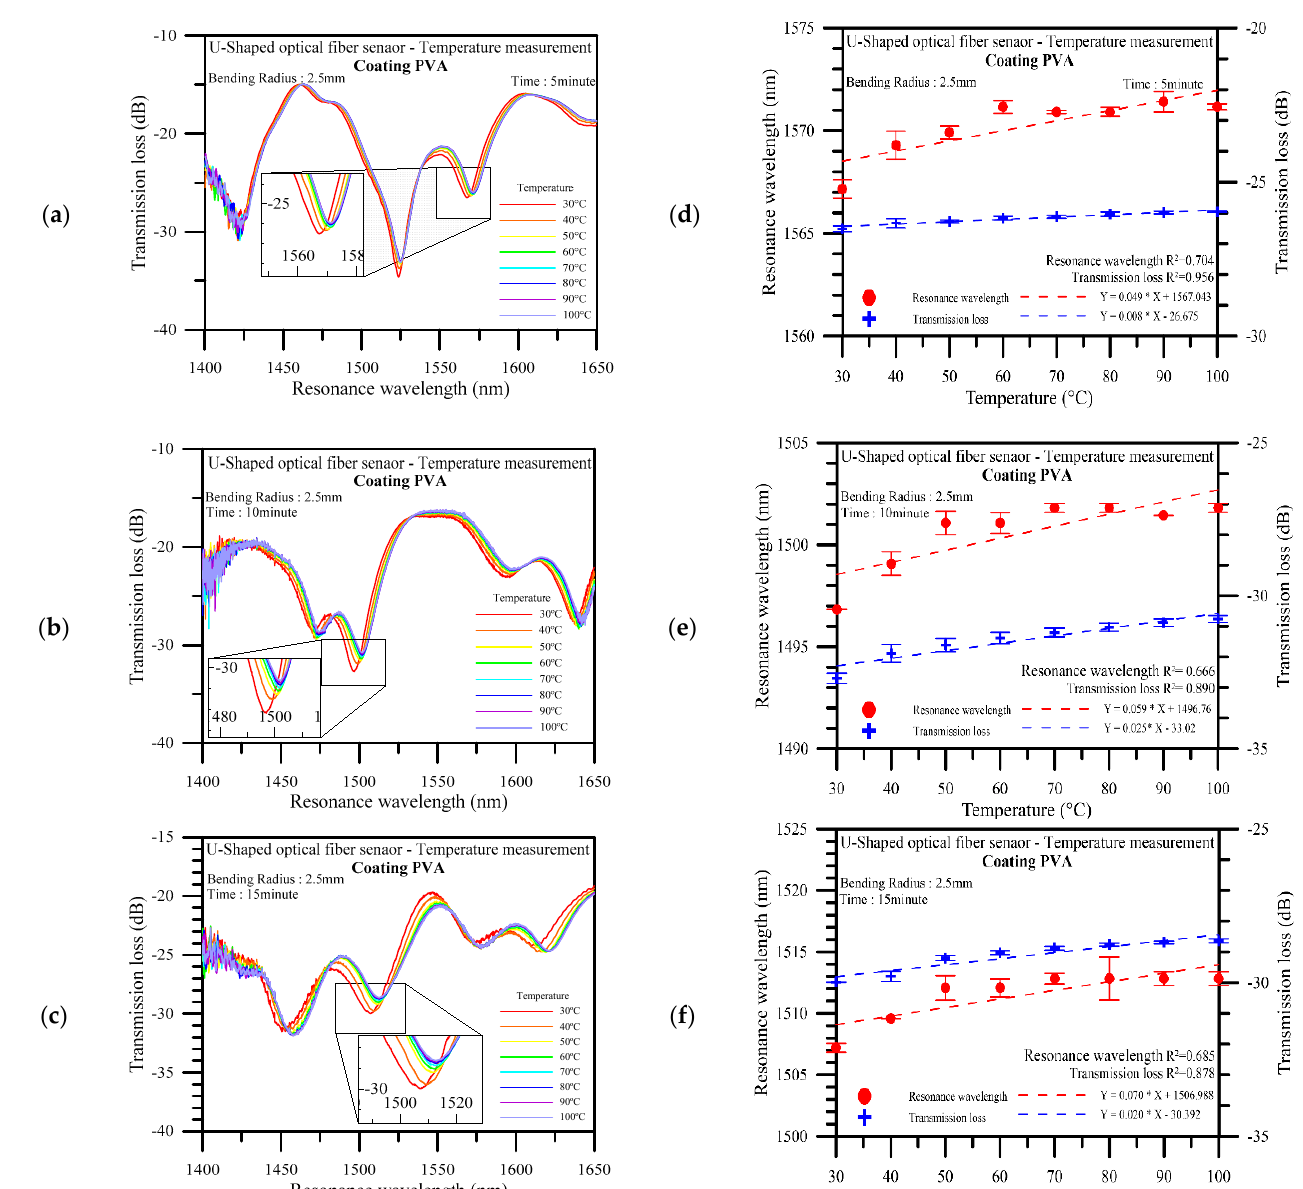
Figure 9. Spectrum generated at an electrospinning duration of ( a ) 5 min; ( b ) 10 min; and ( c ) 15 min; spectrum analysis with the error bars at an electrospinning duration of ( d ) 5 min; ( e ) 10 min; and ( f ) 15 min.